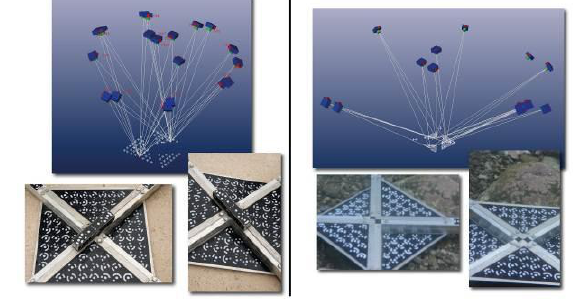
Figure 2. Camera Calibration